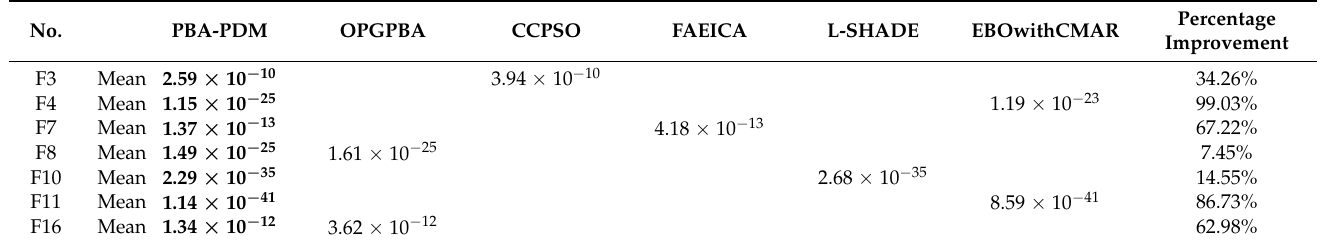
Table 6. Percentage improvement of PBA-PDM compared with secondary